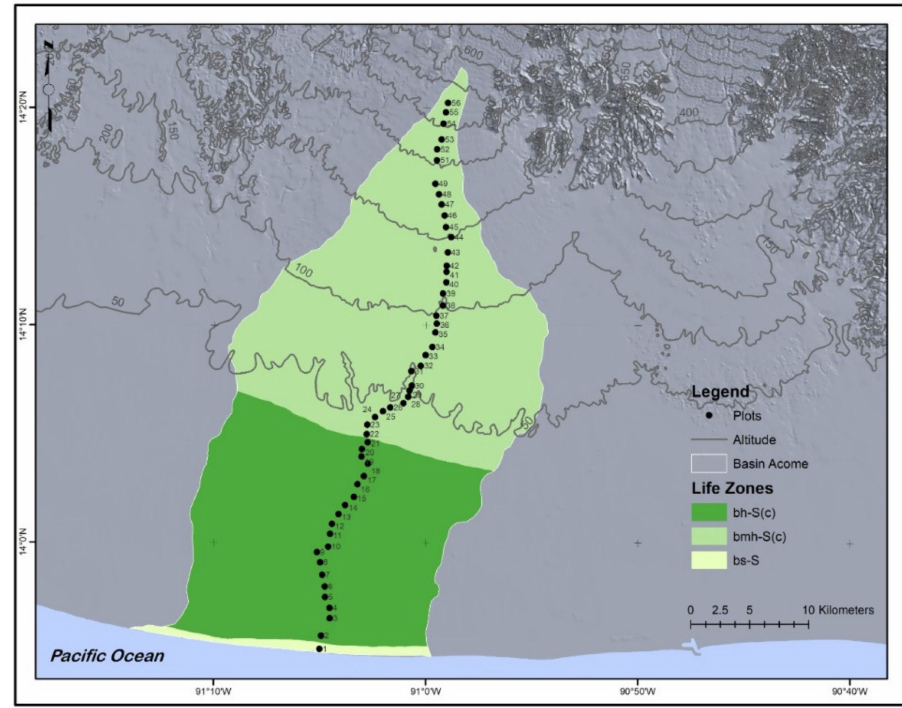
Figure 1. Acom é river basin with its life zones and distribution of the sampling